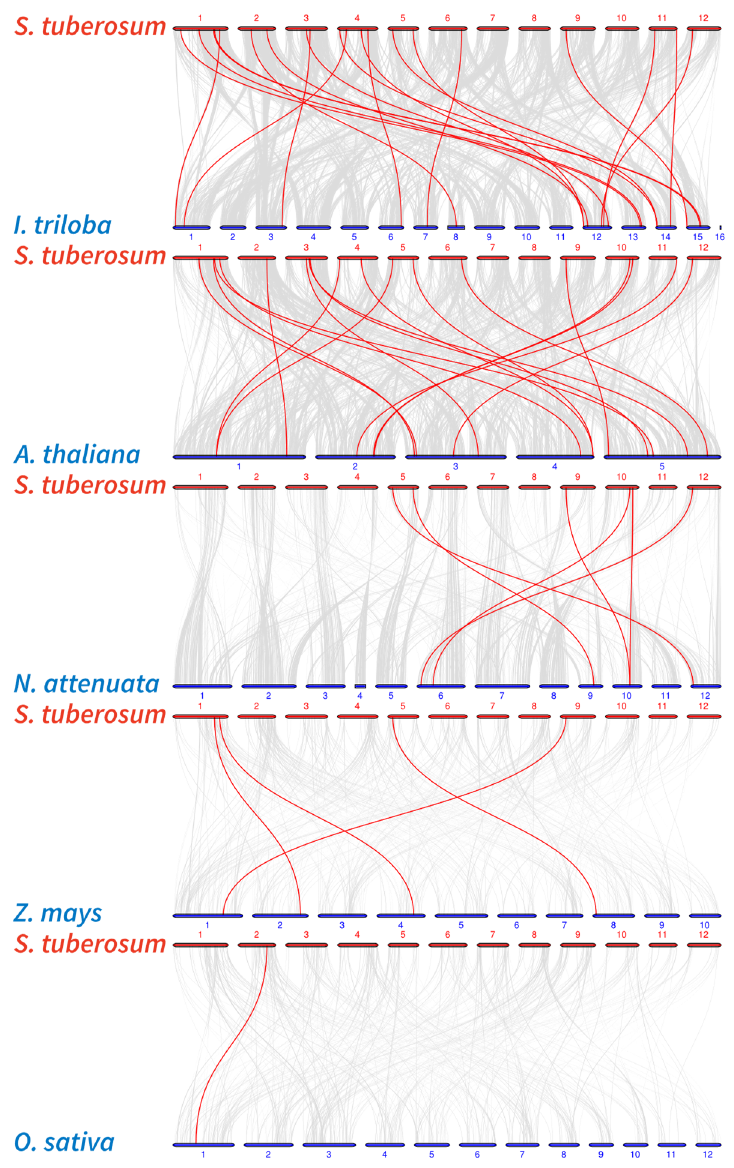
Figure 3. Collinearity analysis of heavy-metal-associated genes between S. tuberosum , I. triloba , A. thaliana , N. attenuate , Z. mays , and O. sativa . Gray lines in the background indicate the collinear blocks within potato and other plant genomes, while the red lines highlight the syntenic StHMA pairs of orthologous genes. The species names with the prefixes “ I. triloba ,” “ A. thaliana ,” “ N. attenuate ,” “ Z. mays ,” and “ O. sativa ” indicate Ipomoea triloba , Arabidopsis thaliana , Nicotiana attenuata , Zea mays , and Oryza sativa , respectively. Blue color bars represent the chromosomes of different species. The chromosome number is labeled at the top or bottom of each